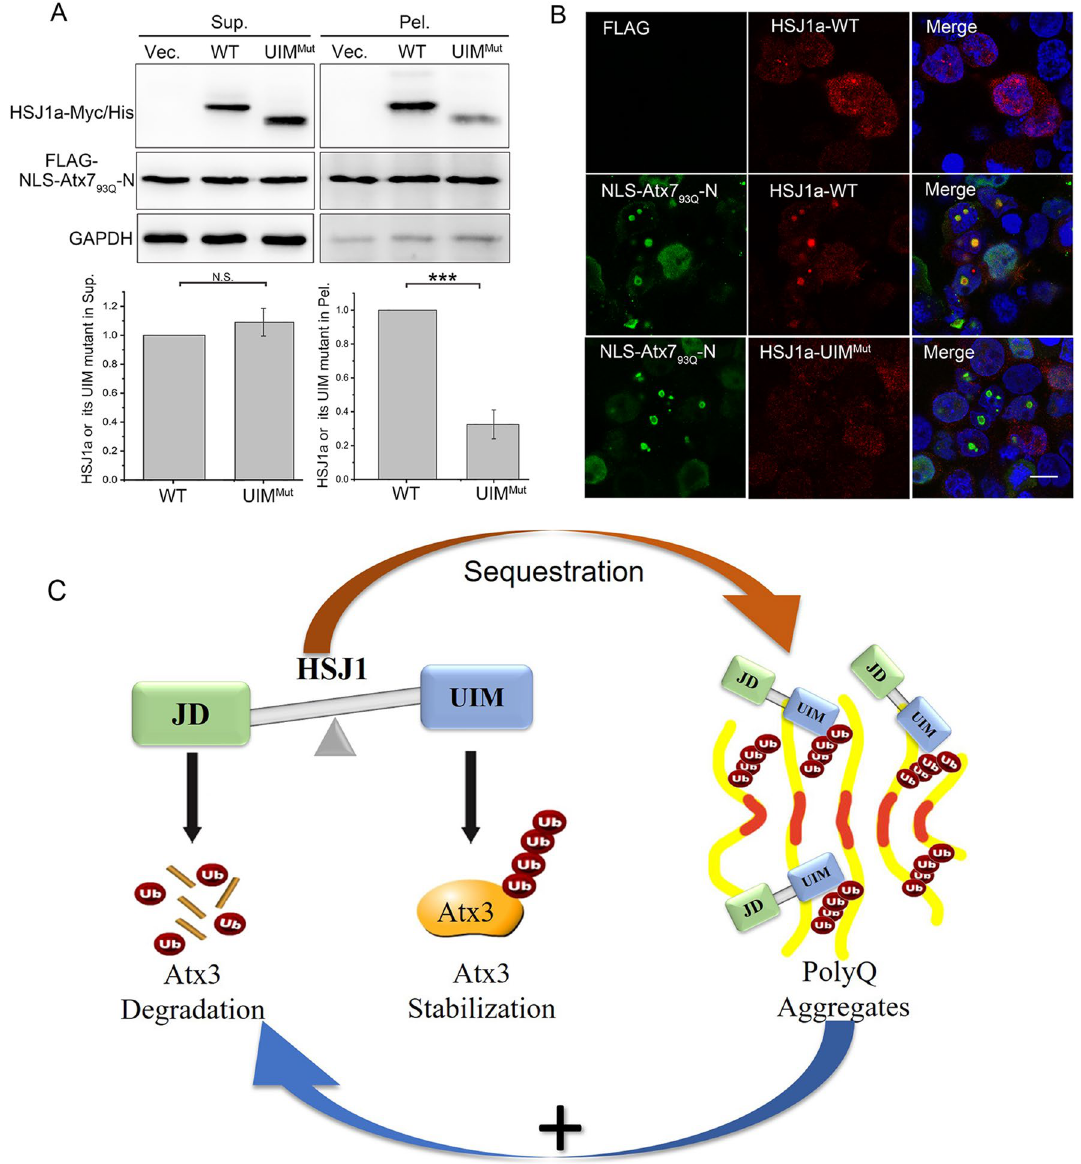
Figure 6. Sequestration of HSJ1 by the polyQ aggregates is mediated by the UIM domain of HSJ1. ( A ) UIM mutation suppresses the sequestration of HSJ1a into aggregates. HSJ1a-Myc/His or its UIM mutant was co-expressed with NLS-Atx7 93Q -N172 in HEK 293T cells, the cell lysates were subjected to supernatant/pellet fractionation, then HSJ1a or its UIM mutant was detected by Western blotting. Sup., supernatant; Pel., pellet. Data are shown as Means ± SEM (n = 3). *** p < 0.001. N.S., no significance. ( B ) Sequestration of HSJ1a or its UIM mutant into polyQ inclusions as visualized by confocal microscopy. HSJ1a-Myc/His or its UIM mutant was co-expressed with NLS-Atx7 93Q -N172 in HEK 293T cells, then the cells were subjected to immunofluorescence imaging. NLS-Atx7 93Q -N172 were stained with anti-FLAG antibody (green), HSJ1a-Myc/His or its UIM mutant was stained with anti-Myc/His antibody, and nuclei were stained with Hoechst (blue). Scale bar = 10 μm. ( C ) Schematic representation of the impaired proteostasis of Atx3 caused by polyQ aggregates through sequestration of HSJ1. Under the normal conditions, HSJ1 balances the degradation and stabilization of Atx3 (brown) through coordinating the functions of its JD and UIM domains, and thus maintains the cellular proteostasis of Atx3. The PQE protein (yellow) forms insoluble aggregates via its polyQ tract (red bar), interacts with HSJ1 via its conjugated Ub molecules (red ball), and sequesters HSJ1 into the aggregates. The sequestration of HSJ1 may cause depletion or dysfunction of the co-chaperone and consequently impairs the cellular proteostasis of